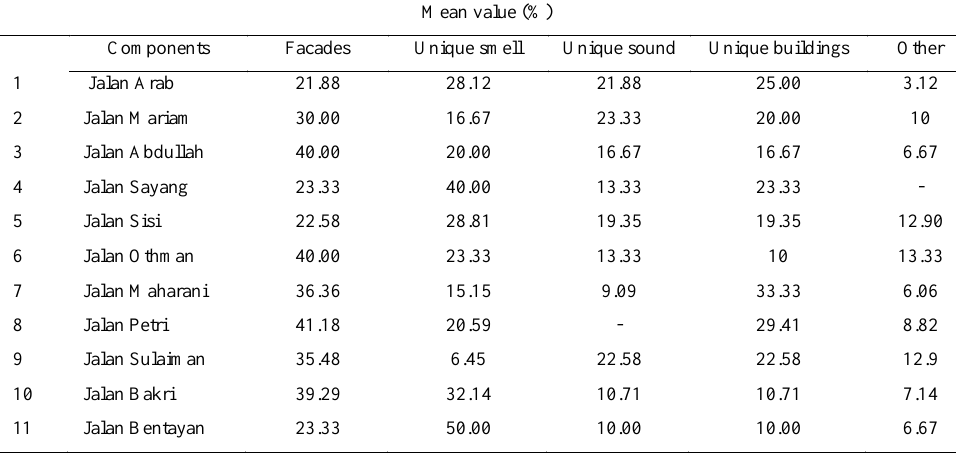
Table 2: Degree of orientation between streets’ components in Muar town